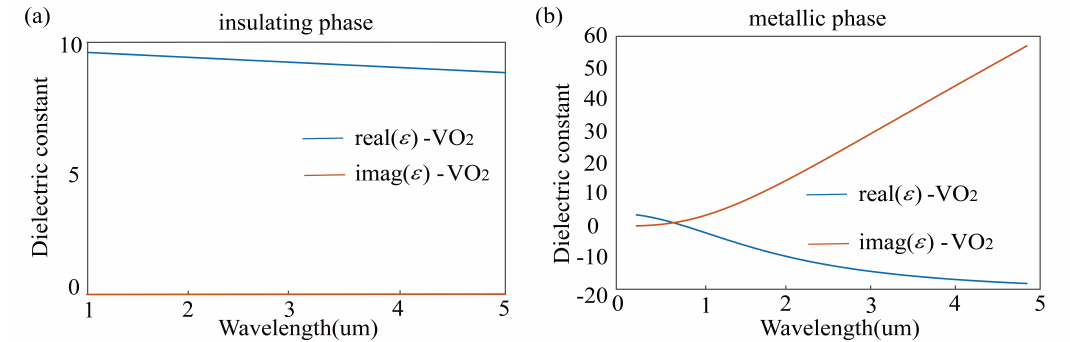
Figure 2. ( a ) Dielectric constant of VO 2 in its low-temperature insulator phase. ( b ) Dielectric constant of VO 2 in its high-temperature metallic phase.